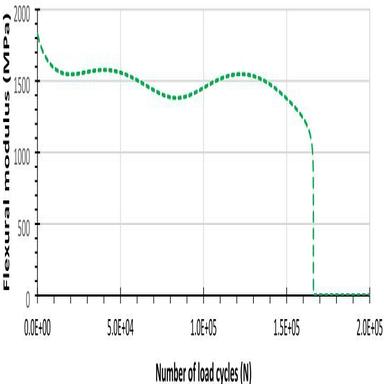
Simulated results of stress-controlled modulus degradation for temperature variation shown in.